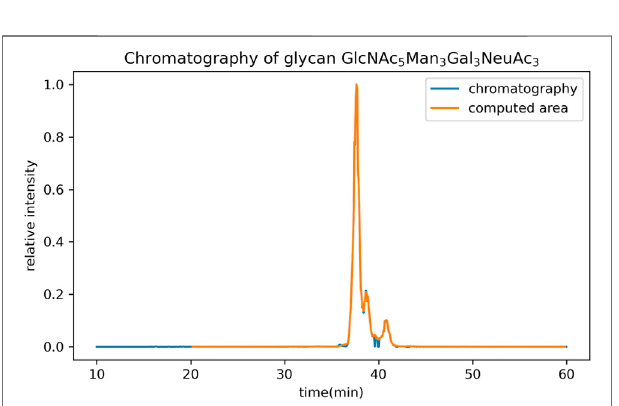
FIGURE 5 | The comparison of extracted ion chromatograms reported by GlycanGUI, and by manual extraction using Xcalibur, respectively. The intensity is normalized to the highest intensity.